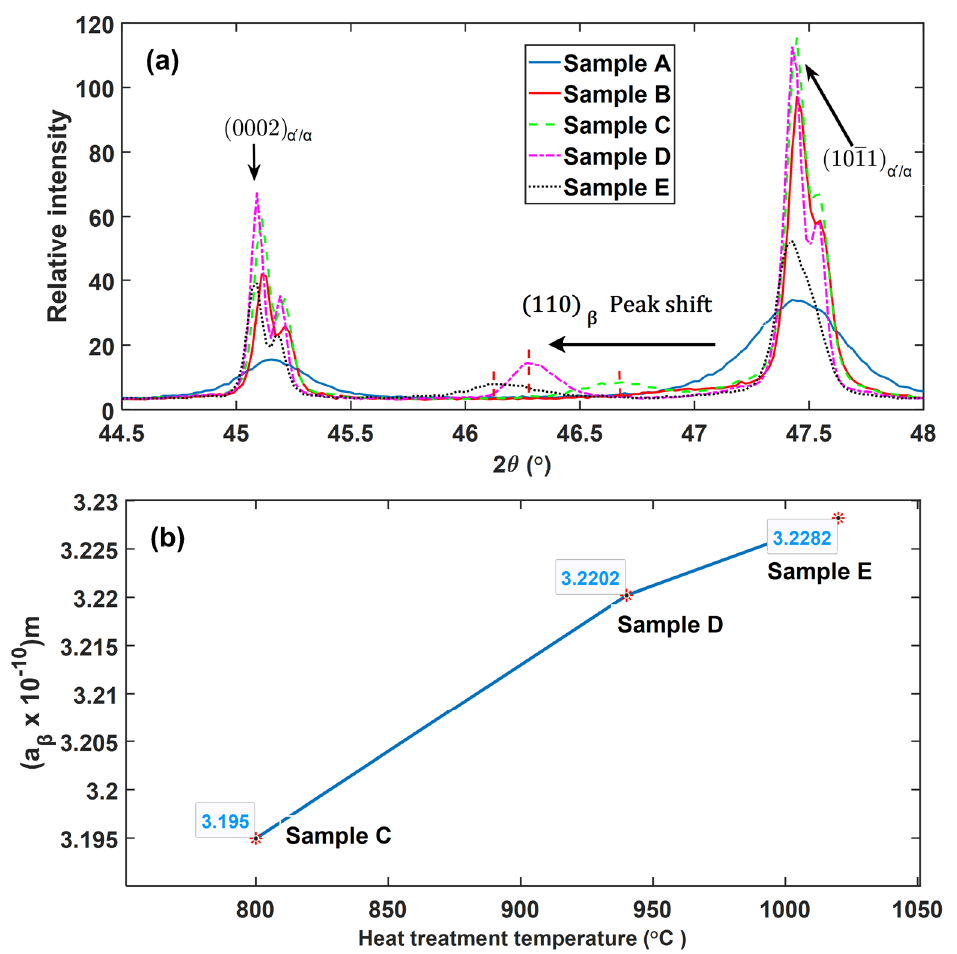
Figure 7. ( a ) The magnification of selected peaks (110) β , (0002) α ՛ /α , and ( 101(cid:3364)1 ), ( b ) Evolution of the β - phase lattce parameter {a} with heat treatment temperatures.